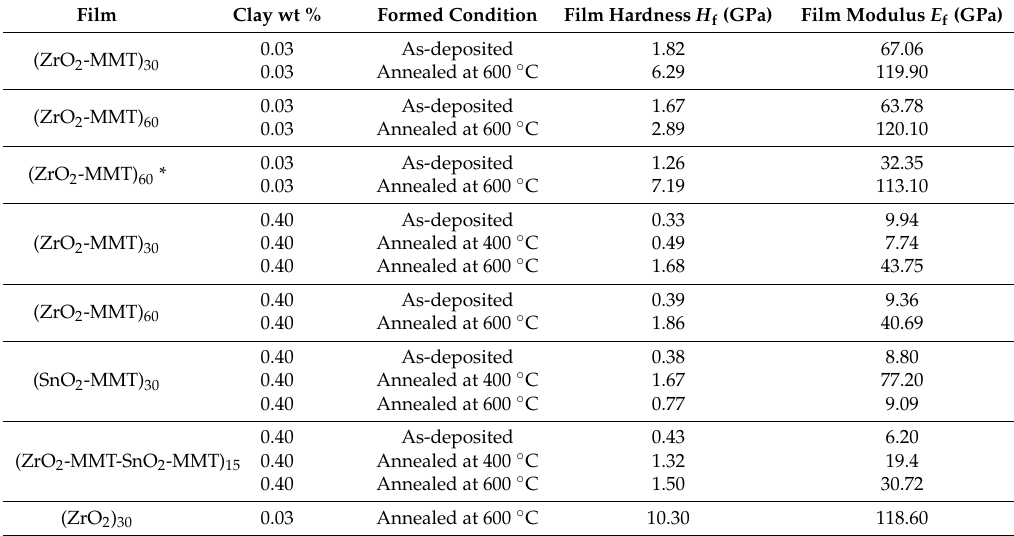
Table 1. Summary of prepared clay-based multilayers, treatment method and mechanical